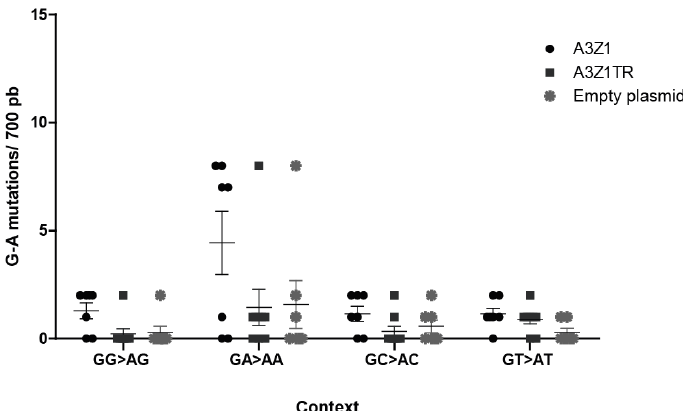
Figure 7. Nucleotide context of deamination. G to A mutations average in gag sequences obtained from ovine skin fibroblast (OSF) infected with SRLVs produced in OSF expressing A3Z1, A3Z1Tr or empty plasmid. Edited clones (A3Z1 n = 7, A3Z1Tr n = 9, Empty plasmid n = 7) in gag gene were aligned and analyzed with the Hypermut 2.0 program